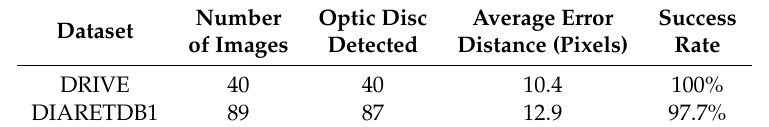
Table 1. Results of the proposed method.